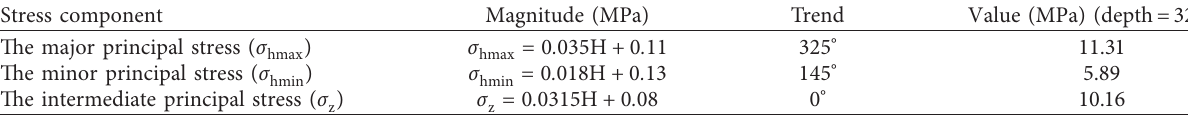
Table 2: In situ stress components at SW orebody of Xinli mine